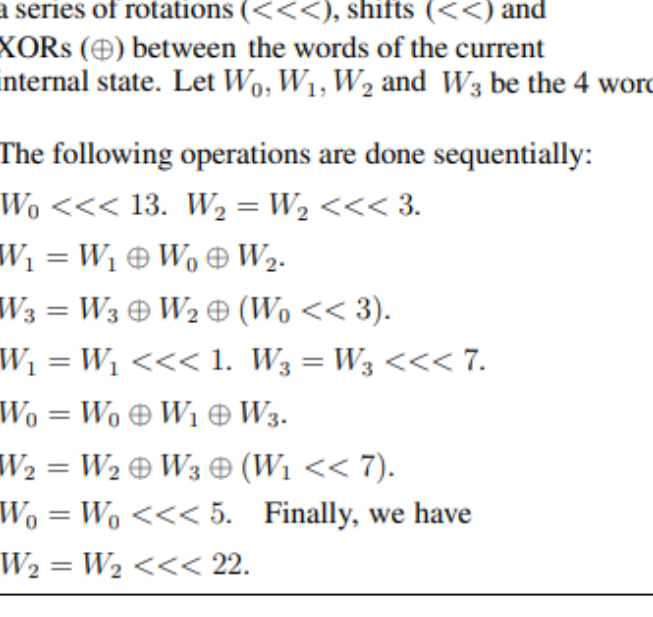
Figure 2. 32-round function of